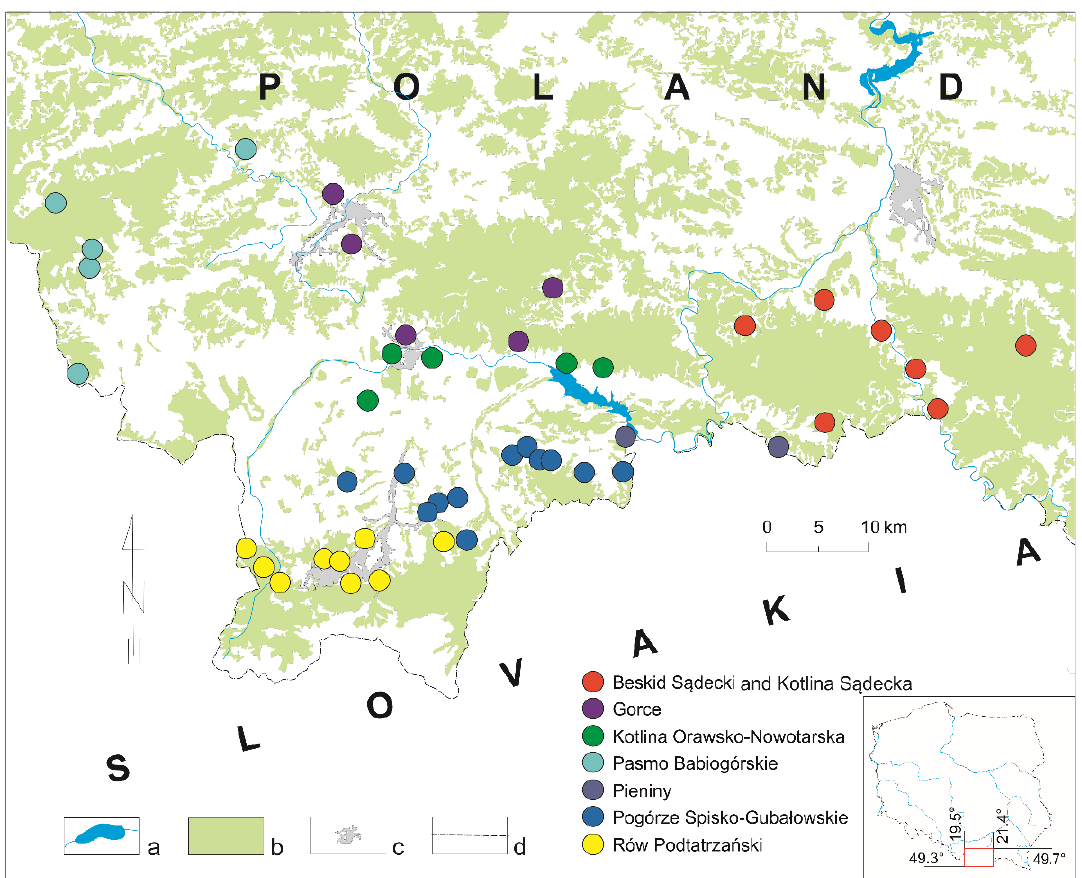
Figure 2. Locations of the grazing sites within regions in the Polish Carpathians. The regions are displayed as colored circles. Explanations: a ) rivers and water bodies, b ) forests, c ) localities, d ) state border. Table 1. Diversity of grassland types in relation to land use in the past. Land use in the 1960s: G- grassland; A-arable fields.